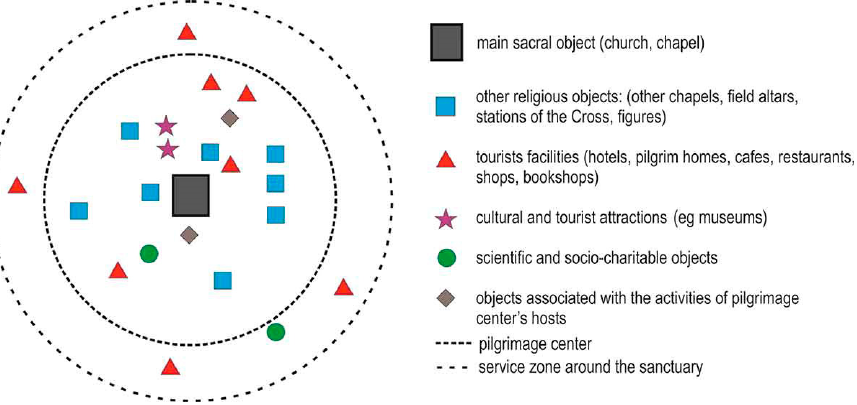
Figure 1. A model of the contemporary pilgrimage center (Figure 3; So ł jan and Liro 2020).